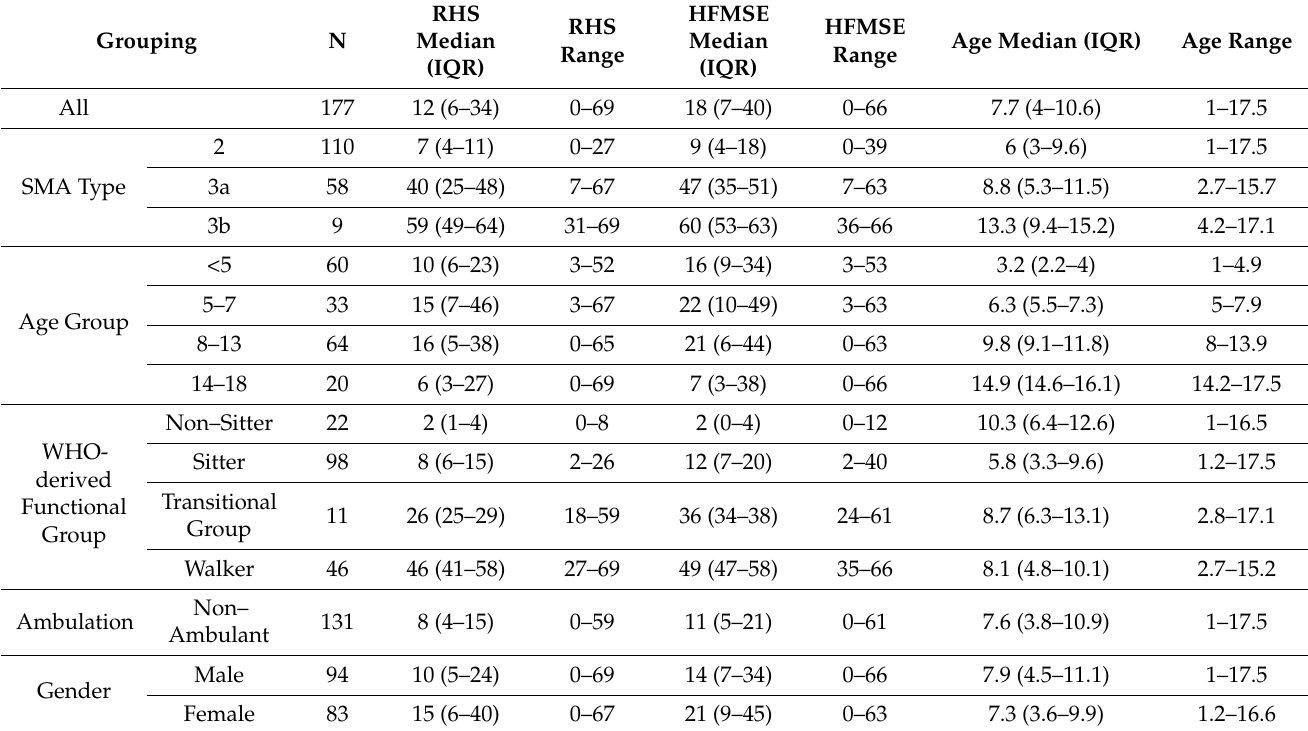
Table 1. Patient first visit RHS and HFMSE scores, and ages by SMA type, age, and motor